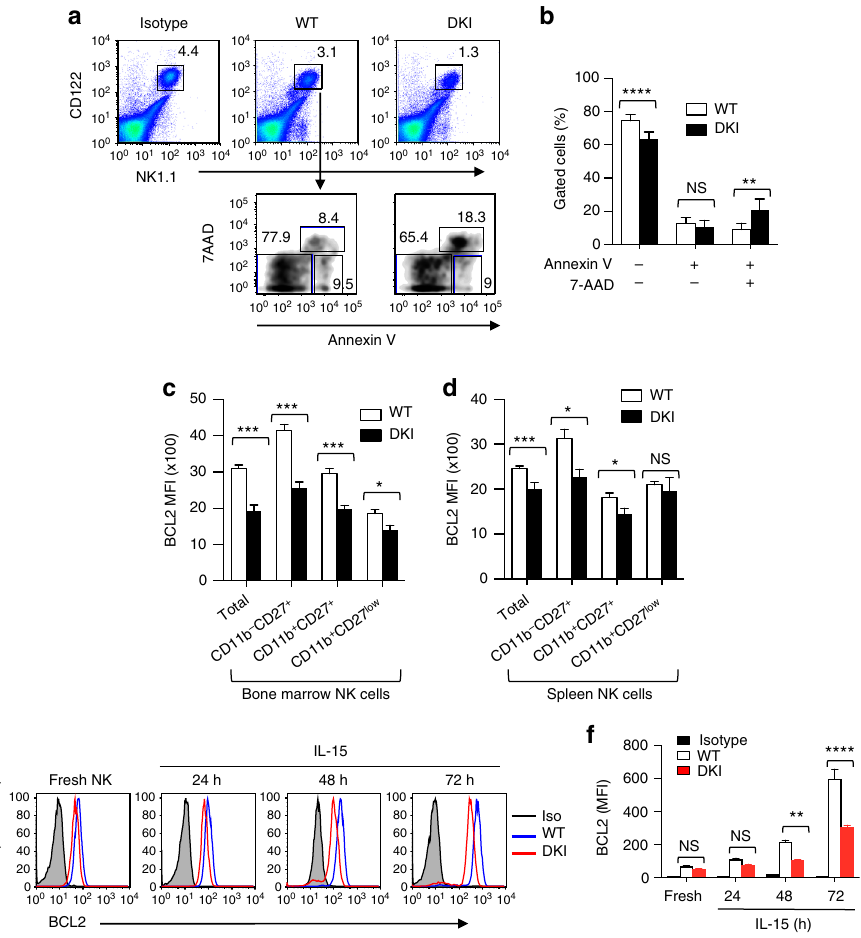
Fig. 5 Increased apoptosis and decreased BCL2 expression as well as increased cytokine withdrawal-induced cell death in Stat5 DKI NK cells. a , b Freshly isolated total spleen cells were stained with anti-CD3, anti-CD122, anti-NK1.1, Annexin V, and 7AAD. Apoptotic NK cells were identi fi ed as CD3 − CD122 + NK1.1 + Annexin V + , and dead NK cells were identi fi ed as CD3 − CD122 + NK1.1 + Annexin V + 7AAD + (lower panels of a ). Percentages of apoptotic and dead cells in splenic NK cells from 7 WT (open bars) and 7 Stat5 DKI ( fi lled bars) mice b . c , d BCL2 expression (MFI) of bone marrow ( c ) and spleen ( d ) NK cells. e Time course of BCL2 expression in splenic NK cells cultured with 20 ng ml − 1 IL-15; BCL2 levels were determined by fl ow cytometry. Isotype control antibody (shaded in grey) and BCL2 antibody staining of WT (blue) and Stat5 DKI (red) NK cells are shown. f BCL2 expression levels (MFI) in IL-15-stimulated splenic NK cells from 3 WT (open bars) and 3 Stat5 DKI (red bars) mice. The experiment was performed twice. Error bars in b , c , d and f are means ± SEM and statistical analyses were performed by grouped multiple t -test using Prism 7.0b type-speci fi c (Fig. 4a, b). By comparing the STAT5 binding sites binding, Il2ra and Bcl2 mRNAs were induced by IL-15 in WT NK identi fi ed in WT cells (bound by STAT5 dimers and/or tetra- cells but not in Stat5 DKI NK cells (Fig. 4g, h). mers) with those identi fi ed in Stat5 DKI cells (bound by STAT5 dimers but not tetramers), we identi fi ed 267 tetramer-speci fi c Rapid cytokine depletion-induced death of Stat5 DKI NK cells . The role of STAT5 tetramers in Bcl2 regulation and the dimin- ished viability of Stat5 DKI NK cells cultured with lower doses of IL-2 or IL-15 led us to further examine the viability of freshly isolated NK cells (Fig. 5a, upper panels). There was a signi fi cant increase in Annexin V + 7AAD + (Grouped Multiple t -test, p < 0.01) but not in the Annexin V + 7AAD − cells among freshly isolated splenic Stat5 DKI NK cells as compared to WT NK cells (Fig. 5a, lower panels and Fig. 5b), consistent with the lower viability in the Stat5 DKI NK cells. Corresponding to our RNA-Seq analysis showing signi fi cantly decreased Bcl2 mRNA in Stat5 DKI NK cells (Fig. 4h), BCL2 protein levels were also signi fi cantly lower in freshly isolated bone marrow (Grouped Multiple t -test, p < 0.001, Fig. 5c) and splenic (Grouped Multiple t -test, p < 0.001, Fig. 5d) Stat5 DKI NK cells than in corre- sponding WT NK cells, and Bcl2 mRNA (Fig. 4h, Supplementary NATURE COMMUNICATIONS | 8: